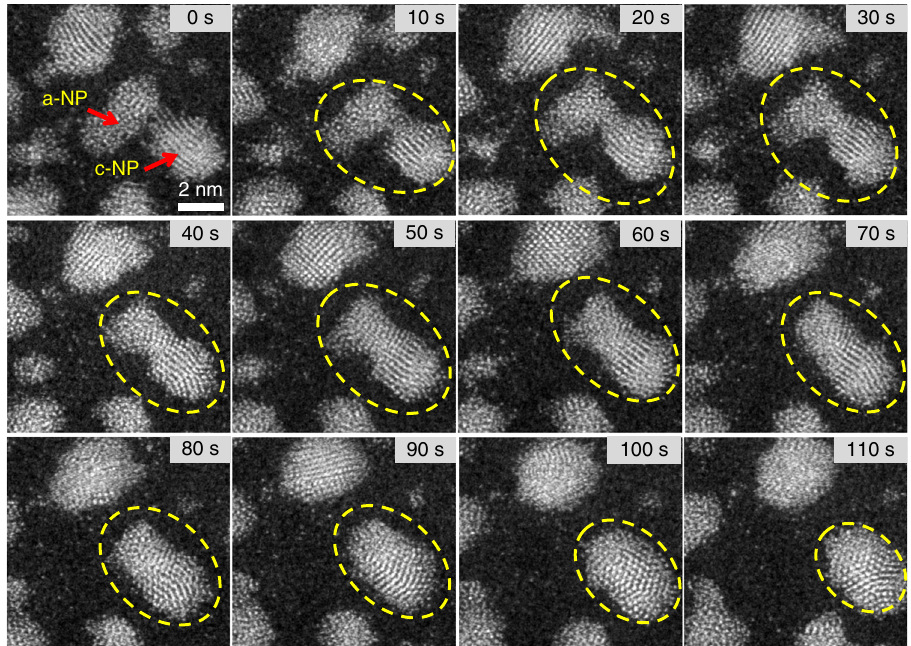
Fig. 6 Cs-STEM images of a coalescence between the a-NP and c-NP. Within 100 s the a-NP approached, contacted and merged into the c-NP